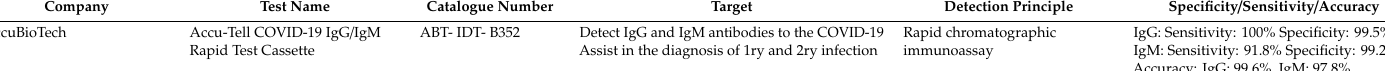
Table A3. Specifications of the commercially available rapid serological tests for laboratory diagnosis of COVID-19.